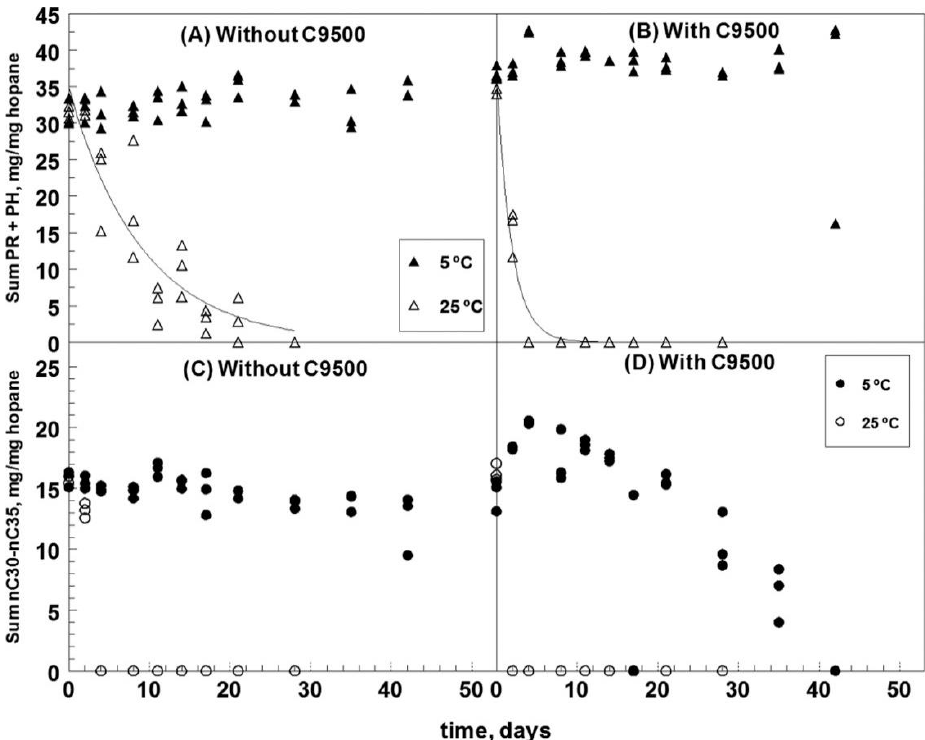
Figure 2. Biodegradation of the branched alkanes ( A , B ) and n -alkanes ( C , D ) > n C 29 in the absence and presence of C9500 dispersant. Adapted from Campo et al. [37]. ( A ) Without C9500, ( B ) With C9500, ( C ) Without C9500, ( D ) With C9500.